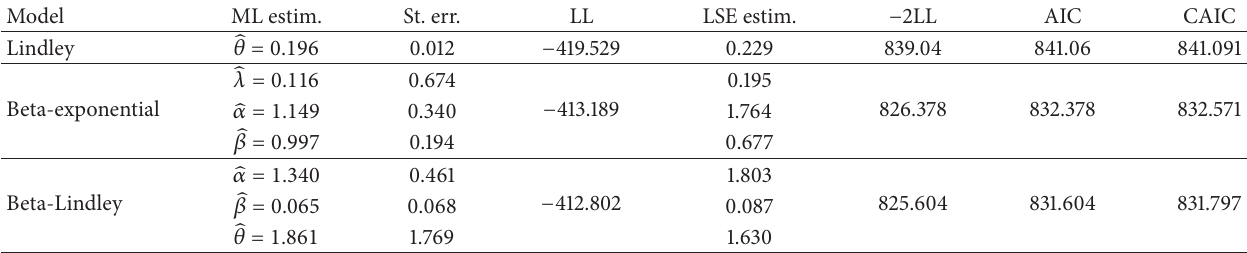
Table 1: The ML estimates, standard error, log-likelihood, LSE estimates, AIC, and CAIC for Data Set 1. Model